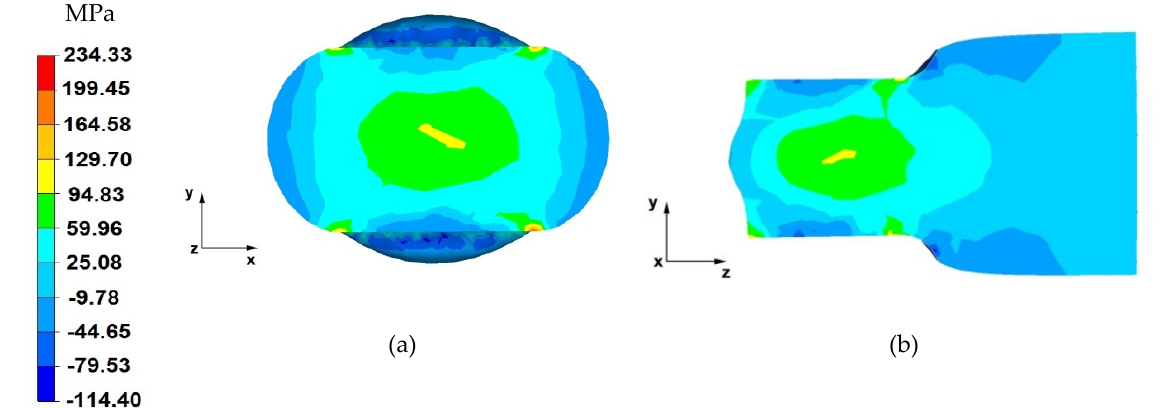
Figure 7. Distribution of the hydrostatic pressure of the AZ 91 alloy forging, deformed in the first pass with 40% reduction in flat anvils: ( a ) on the cross-section, ( b ) on the longitudinal section.